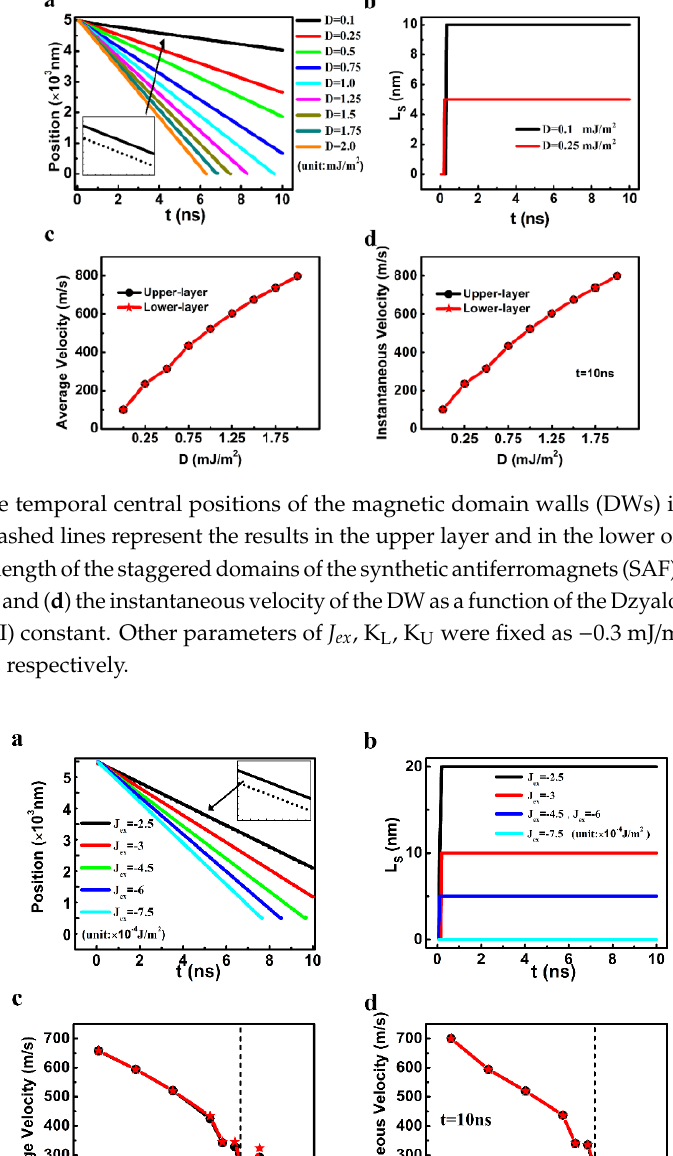
Figure 2. The representative snapshots of the position of the DW and the enlarged figures for the DW structure in the SAF racetrack memory at different times. The magnetic parameters of J ex , D, K U , and K L were fixed as −0.15 mJ/m 2 , 0.75 mJ/m 2 , 5 × 10 5 J/m 3 , and 2.5 × 10 5 J/m 3 .